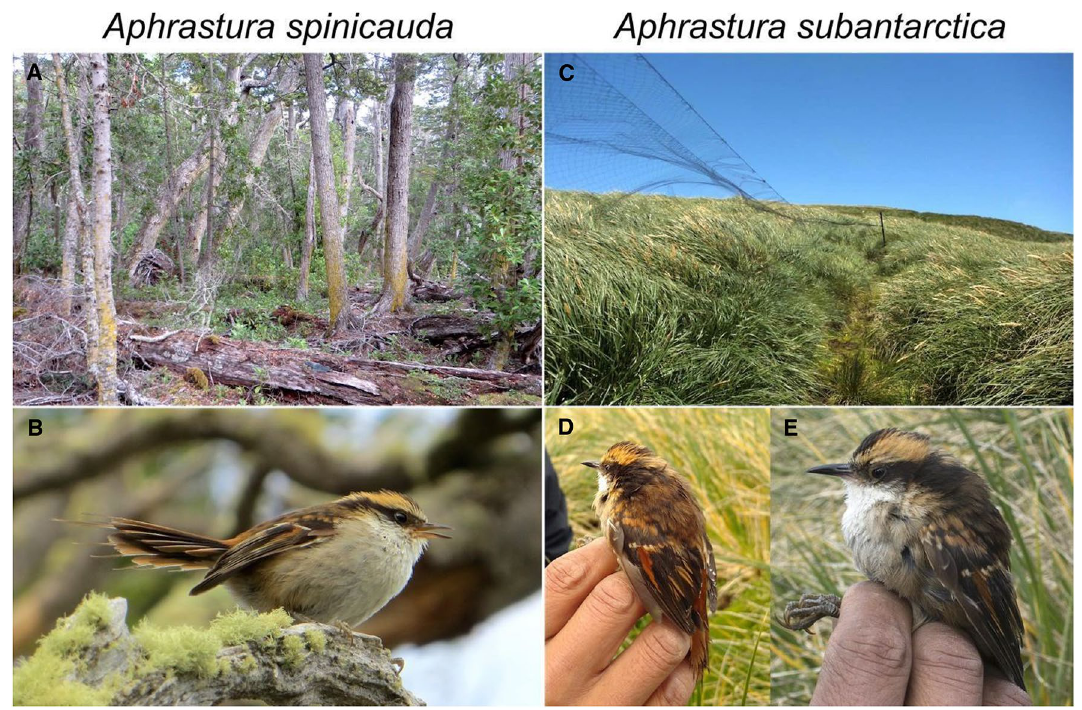
Navarino Island. ( C ) Tussock ( Poa flabellata ) habitat on Gonzalo Island, Diego Ramírez Archipelago, with a mist net. ( D , E ) Individuals of the proposed new species A. subantarctica from Gonzalo Island. Images by Omar